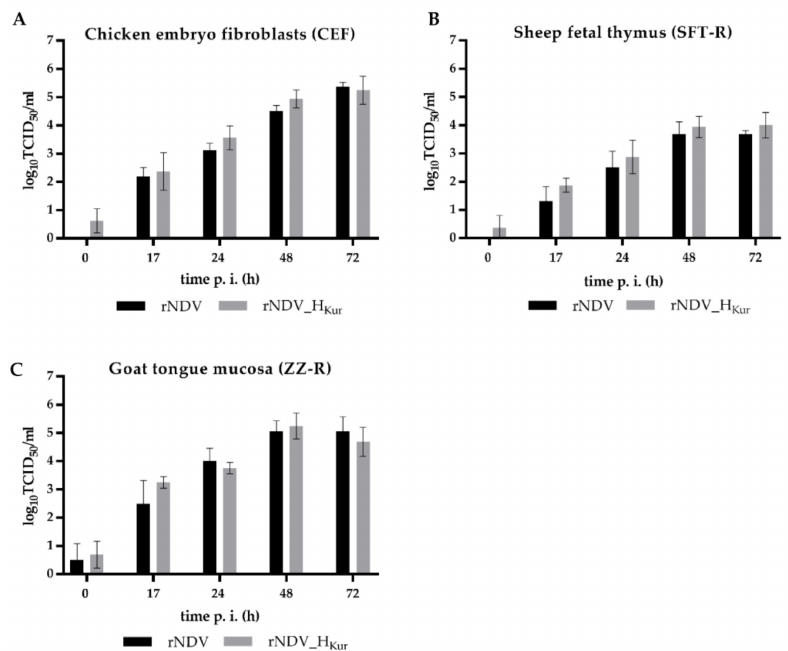
Figure 3. In vitro replication in cell lines originated from di ff erent species. ( A ) Chicken embryo fibroblasts (CEFs), ( B ) ovine fetal thymus cells (SFT-R), or ( C ) caprine tongue mucosa cells (ZZ-R) were infected with rNDV or rNDV_H Kur (moi 0.01). Cell culture supernatants were harvested at indicated time points after infection (p.i.) and titrated on quail muscle (QM9) cells. Viral titers (TCID 50 / mL) were determined by subsequent immunostaining using a hyperimmune serum against NDV and Alexa 488 α -rabbit secondary antibody (Invitrogen). Bar charts depict mean viral titers ± standard deviation ( n = 4, two samples each from two independent